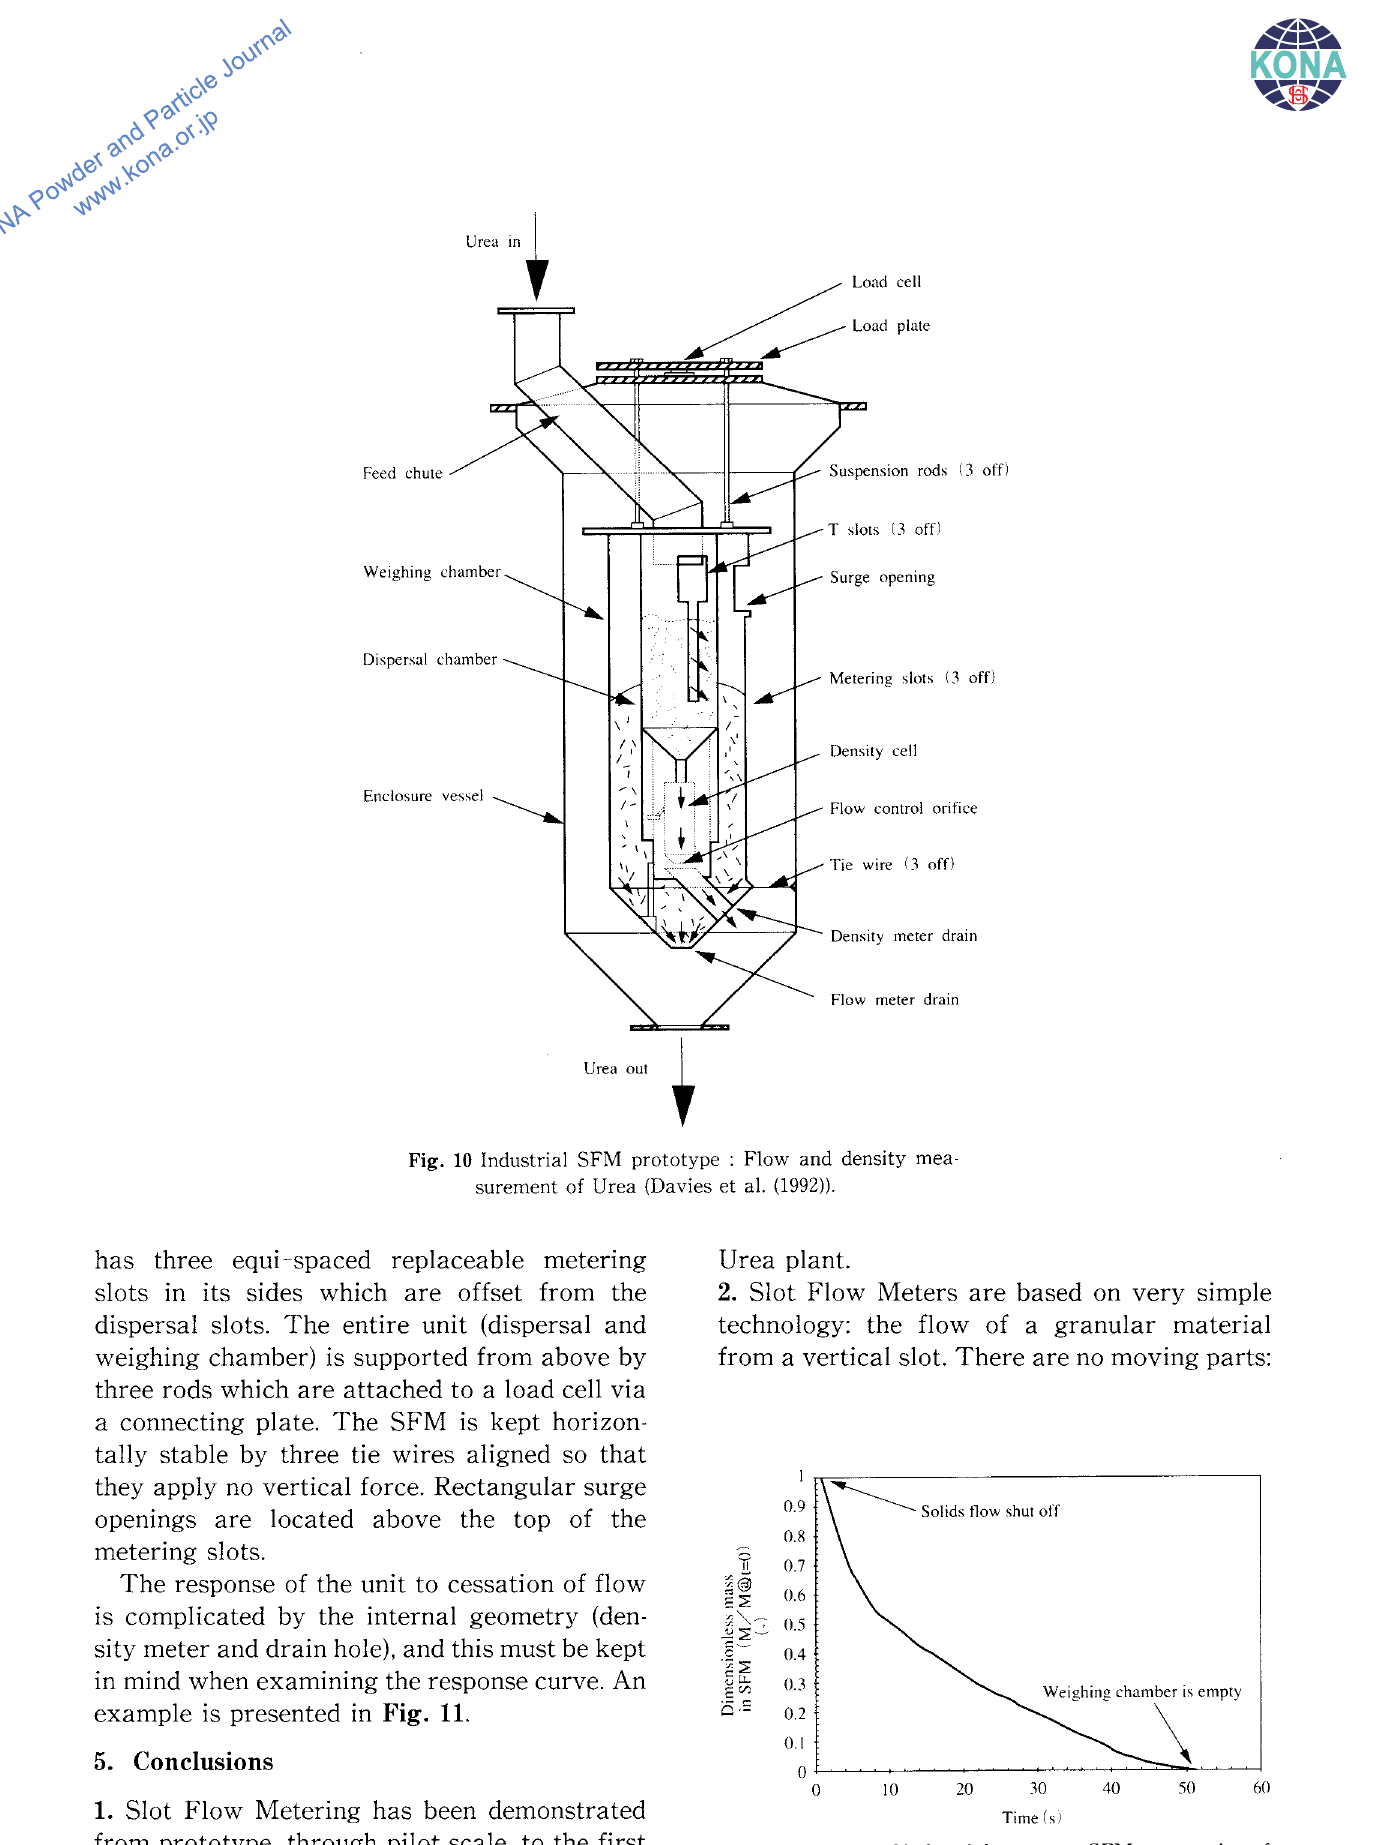
Fig. 11 Response of industrial prototype SFM to cessation of flow, Davies et a!.